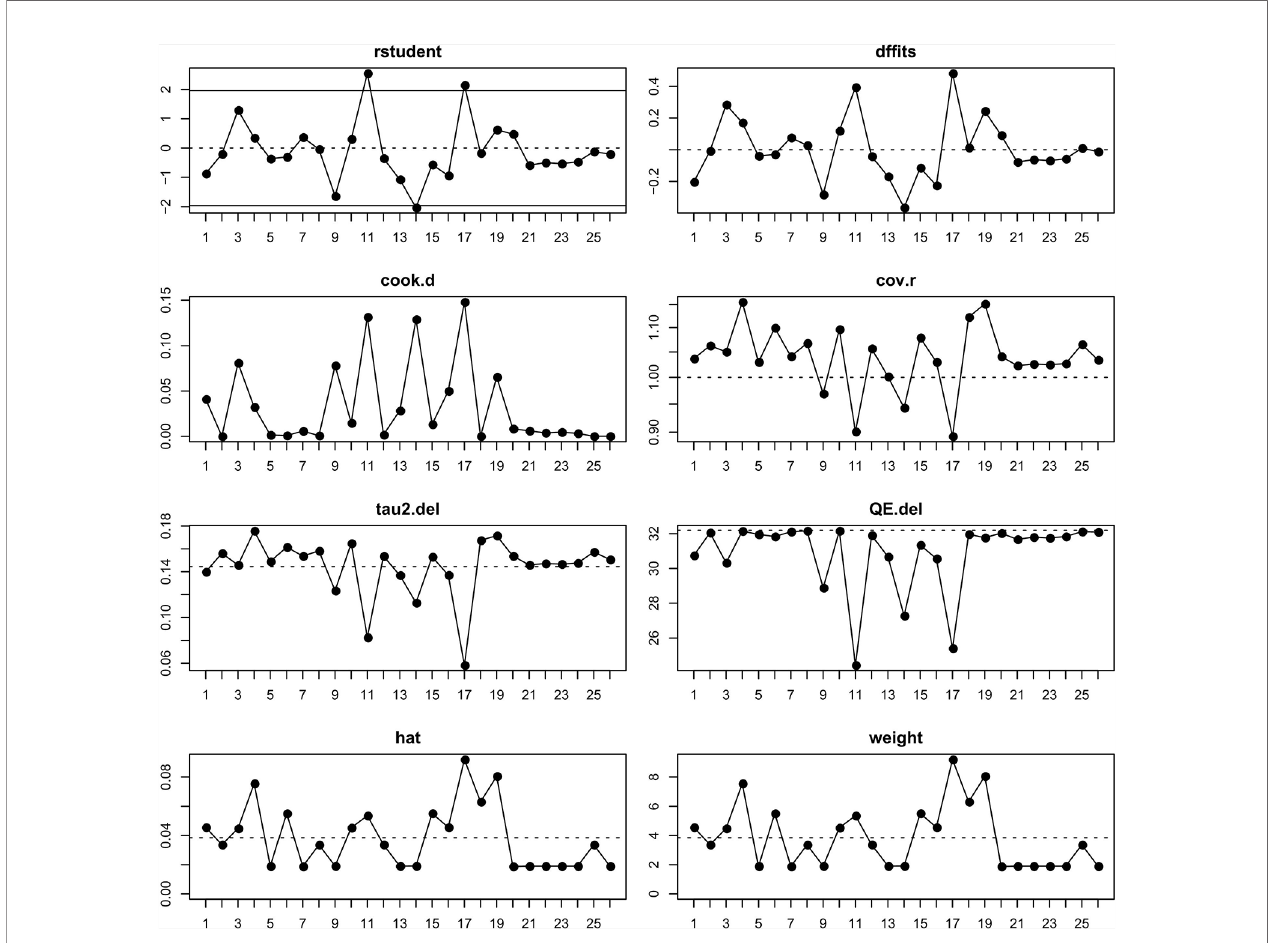
FIGURE 3 | The plot of in fl uential study. The in fl uential studies would be marked with